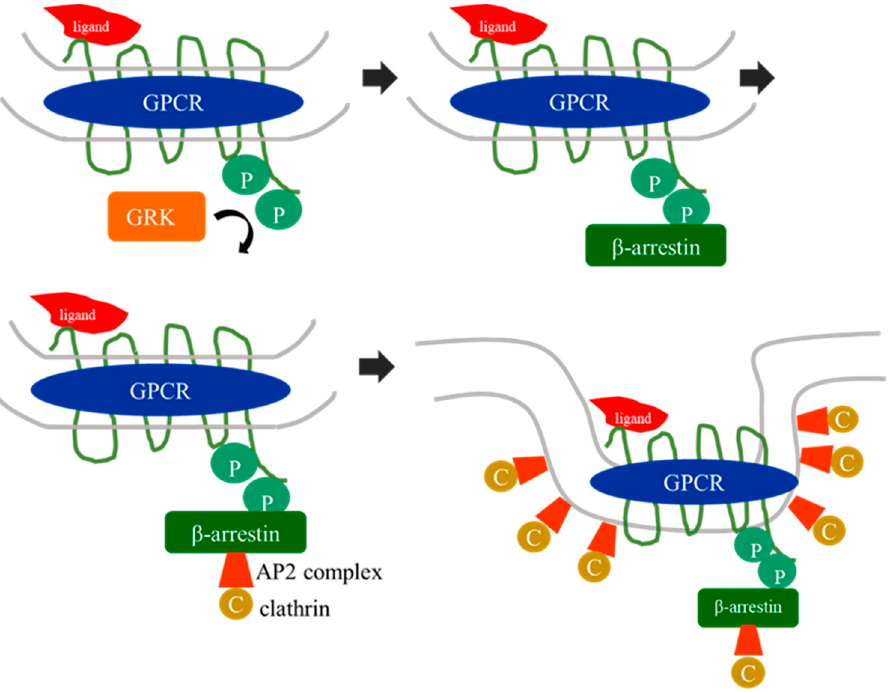
Figure 1. Concept of homologous receptor desensitization (simplified chart). GRK-mediated phos- phorylation of a ligand-bound GPCR leads to recruitment of β -arrestin, which enables accessory protein 2 (AP2) and clathrin binding. Consequently, clathrin-coated pits are set up and the receptor is internalized by dynamin-mediated formation of an endocytic vesicle. P: phosphorylated residues. C: clathrin [22,23].